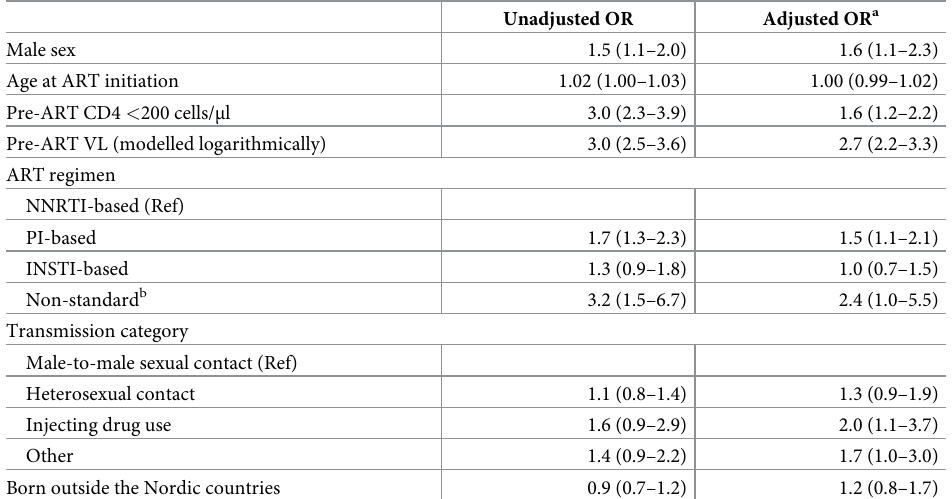
Table 2. Factors associated with low-level viraemia in univariable and multivariable analyses.